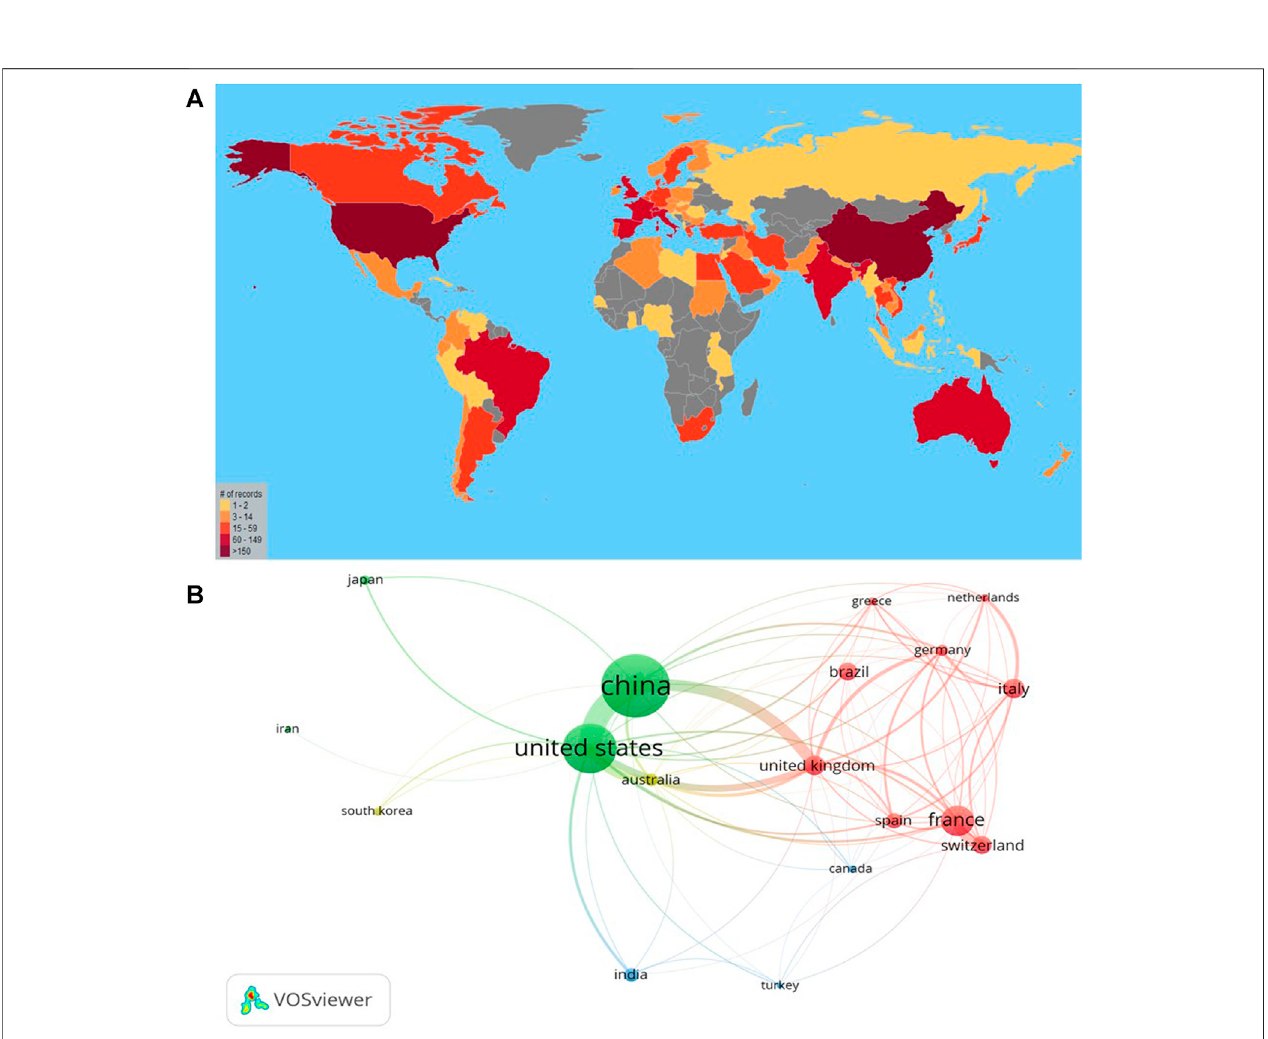
FIGURE 2 | Spatial distribution of publications (A) Geographical distribution of worldwide publications on polymyxin resistance based on author ’ s af fi liation in Scopus (2010 – 2019) (B) Network visualization of inter-country collaborations among countries with a minimum of 20 publications on polymyxin resistance research (2010 –